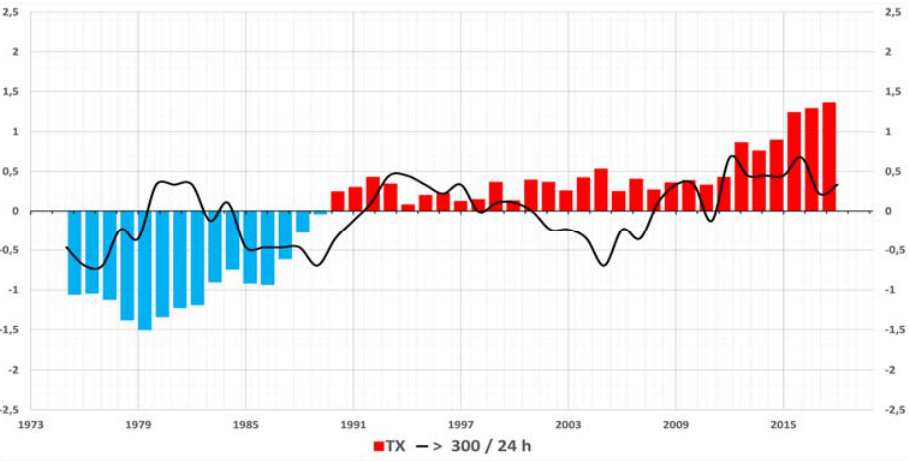
Figure 4. Evolution of centred small deviations of Mediterranean episodes (higher than 300 mm in 24 h) and of regional averages of maximum temperatures (Tx) (five-year moving average) (1973–2020). ( RI = ( 𝑋𝑖 − 𝑋 )/ S ‐ where 𝑋𝑖 is yearly value, 𝑋 is the series average and S is standard deviation).